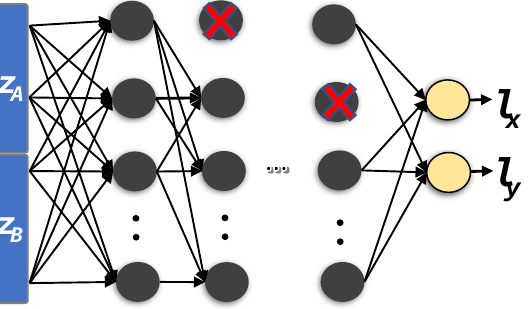
Figure 4. The network structure of the location estimator module. Crossed neurons represent dropped out units to avoid overfitting during